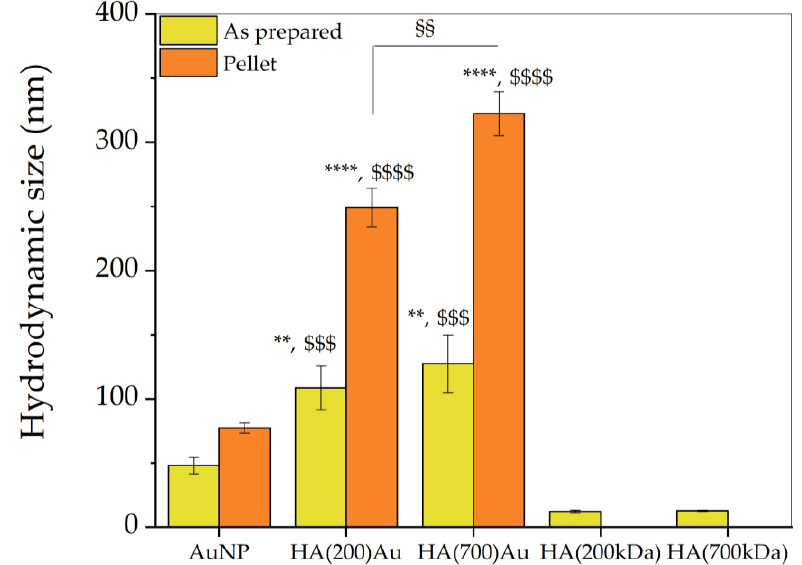
Figure 2. Hydrodynamic size of the bare AuNPs (as-prepared and ‘pellet 2’ samples) and HA-functionalized AuNPs (as-prepared and ‘pellet 3’ samples) measured by dynamic light scattering (DLS). (**) = p < 0.01, (****) p < 0.0001 vs. bare AuNP; ($$$) = p < 0.001, ($$$$) = p < 0.0001 vs. the control HA 200 or HA 700 (one-way ANOVA); (§§) = p < 0.01 vs. HA(200)Au.